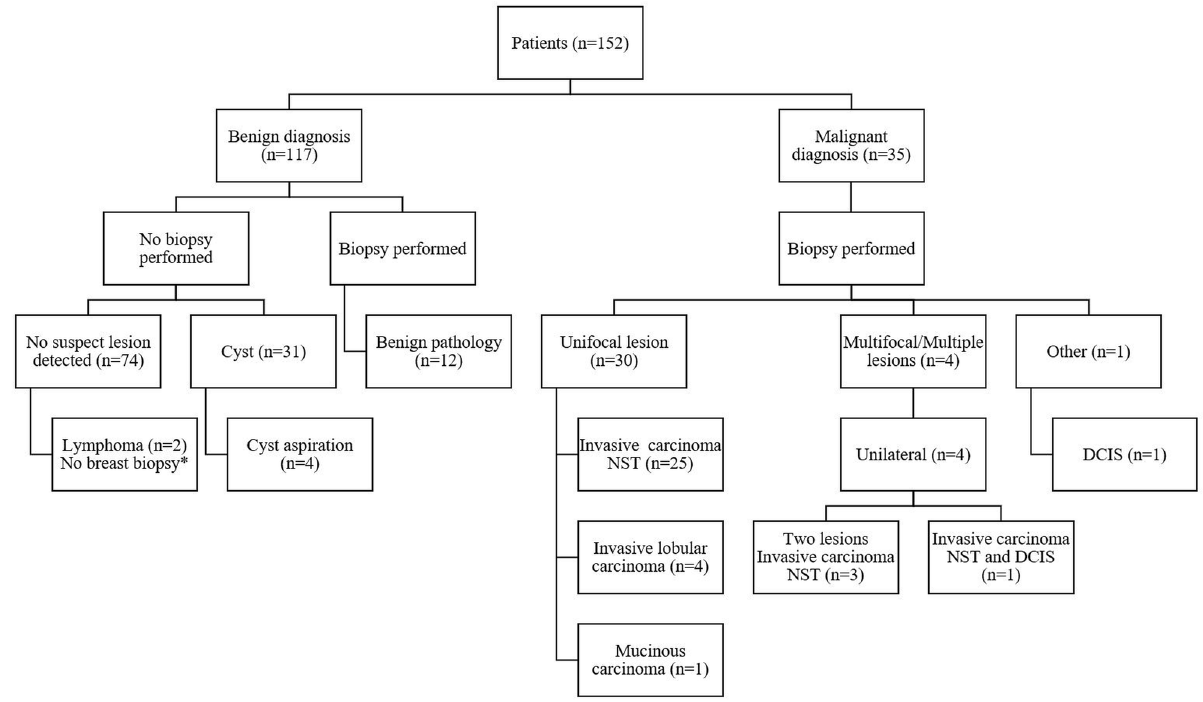
Figure 1. Patient diagnostic flowchart. *Axillary biopsy revealed lymphoma, no suspect lesion on CEM. NST No special type, DCIS Ductal carcinoma in situ, CEM Contrast-enhanced mammography.